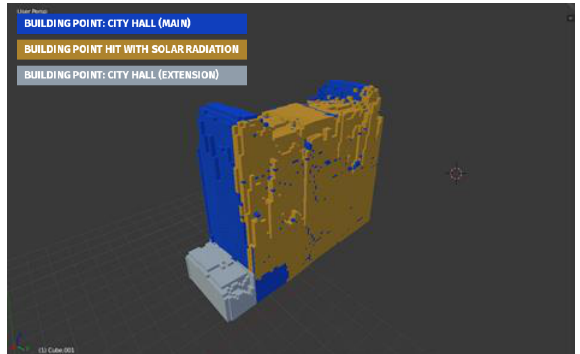
Figure 10. Building Model and Solar Irradiation Model